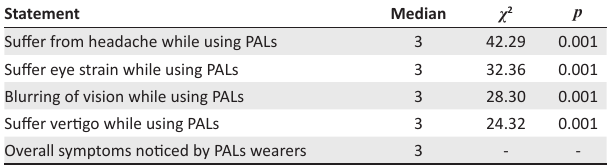
FIGURE 2: Respondents complaints reported associated with progressive addition lenses. TABLE 4: Analysis of respondents’ reported